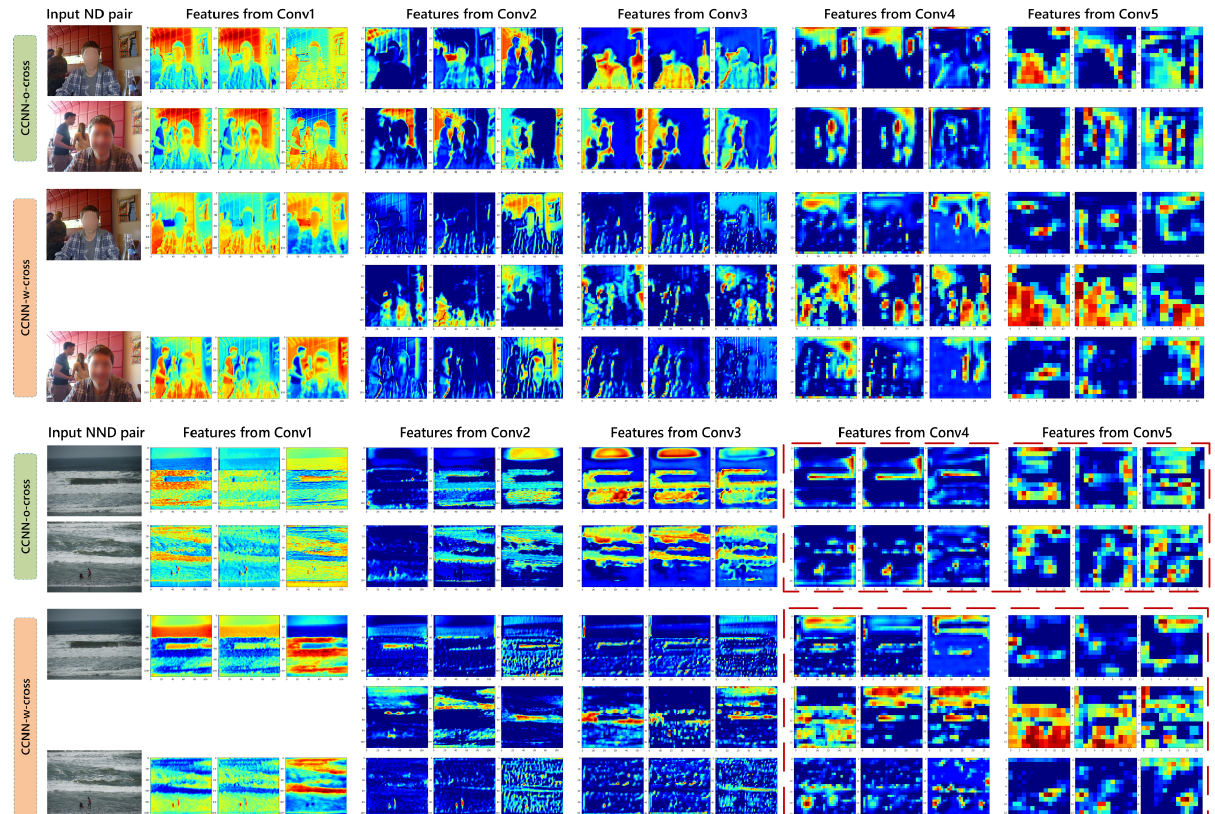
Figure 7. Visualization of the first three slices feature maps on each convolutional set of networks with/without triple stream. As highlighted in the red dashed boxes, for visually similar non-near duplicate (NND) pair, which is easily predicted as near duplicate (ND) by CCNN-o-cross, CCNN-w-cross is able to capture more discriminative information of visually similar NND.